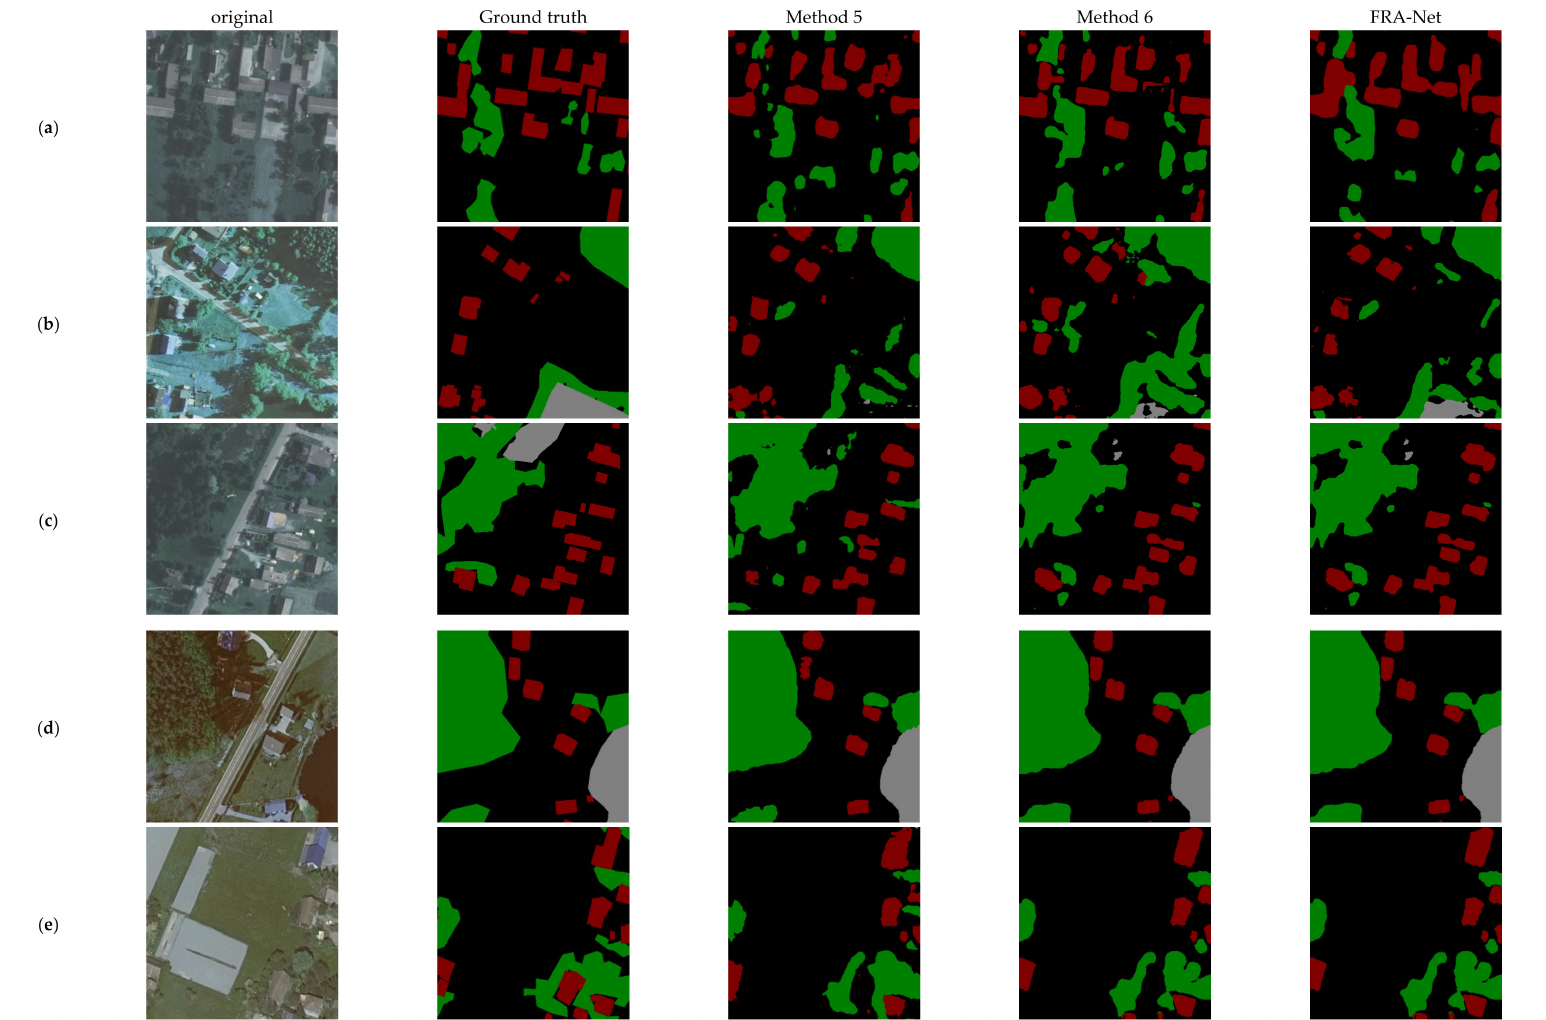
Figure 6. Local prediction of 5–6 sampling methods and FRA-Net in the LandCover dataset, the meaning of colors is buildings (red), woodlands (green), water (grey), and backgrounds (black). ( a – e ) are the experimental results of 5–6 methods and FRA-Net on images from the LandCover